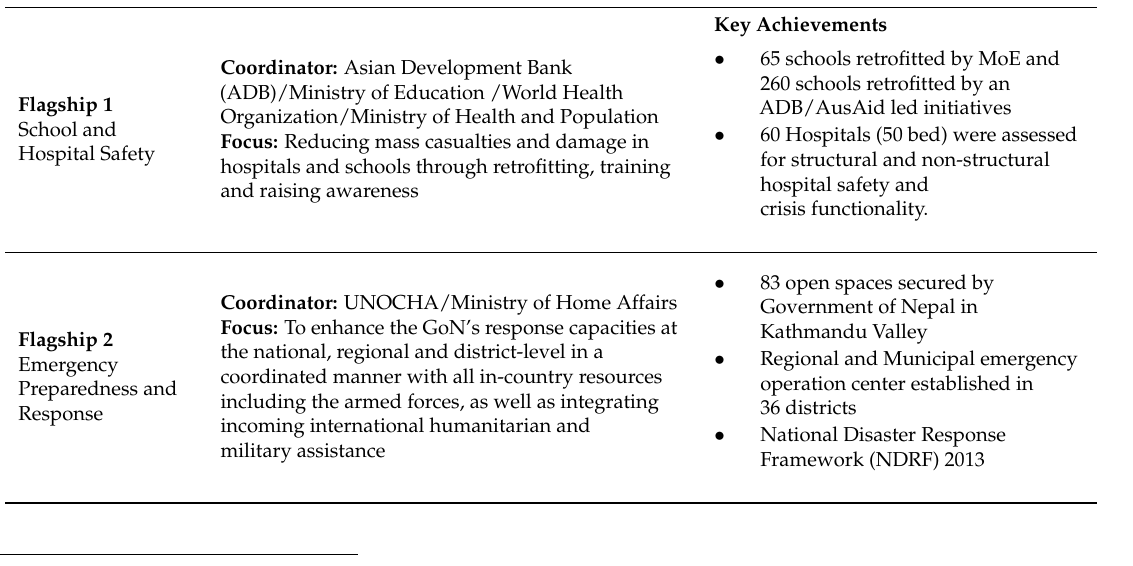
Table 1. Nepal Risk Reduction Consortium’s flagship priority areas with key